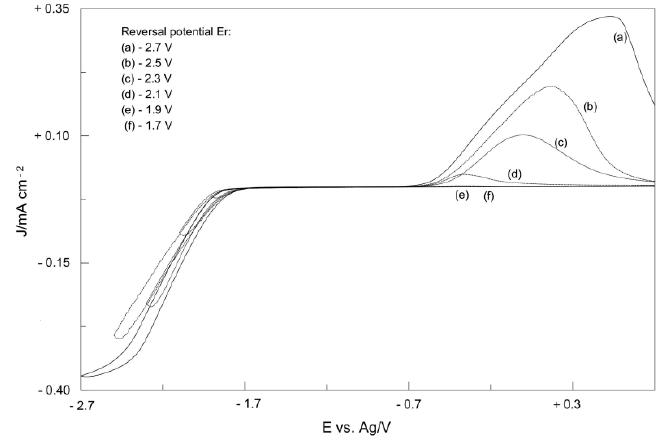
Figure 6. Voltammetric curves of 1-butyl-3-methylimidazolium tetrafluoroborate (BMImBF 4 ). Starting potential: +0.8 V, reversal potential: as reported. GC cathode, ν = 0.2 V·s −1 , Ag quasireversible electrode, T = 60 °C. Reproduced with permission from [31]. Copyright Elsevier,